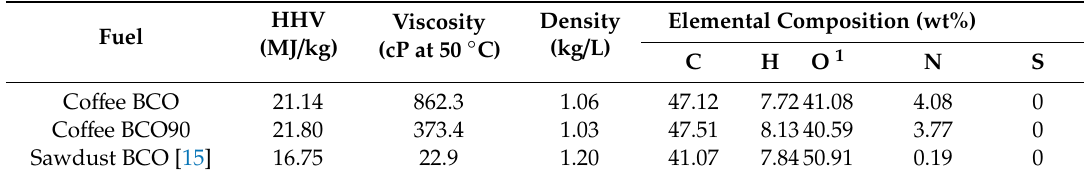
Table 2. Properties of the co ff ee bio-crude oil (BCO)100, 90 and sawdust BCO [15] (wet basis). HHV Viscosity Fuel (MJ / kg) (cP at 50 ◦ C) Co ff ee BCO Sawdust BCO